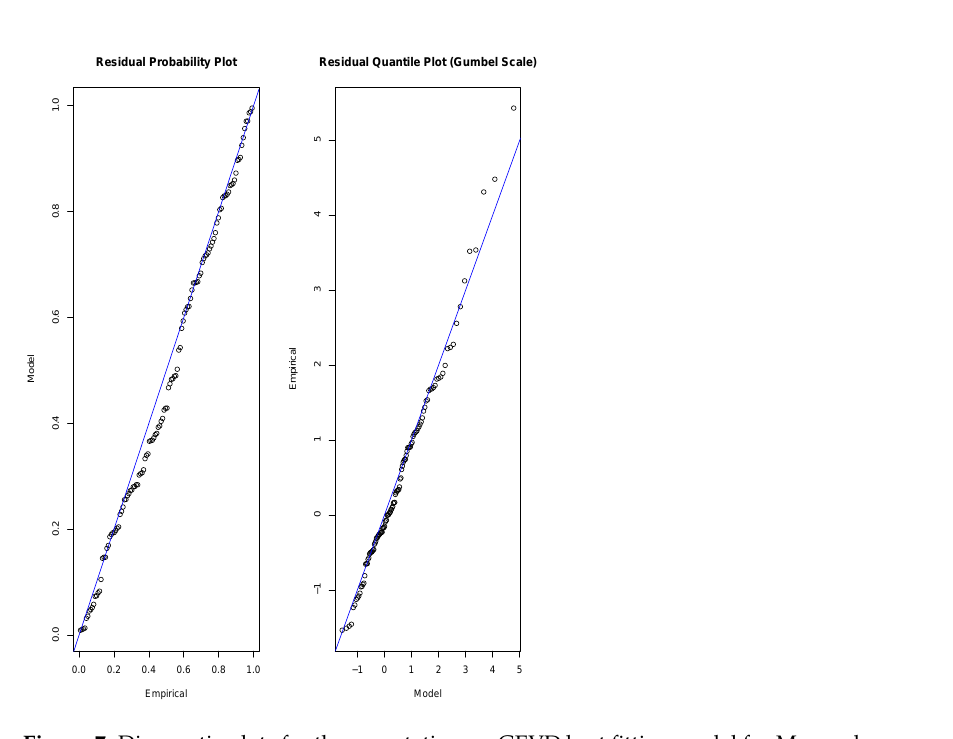
Figure 7. Diagnostic plots for the non-stationary GEVD best fitting model for Mpumalanga province.